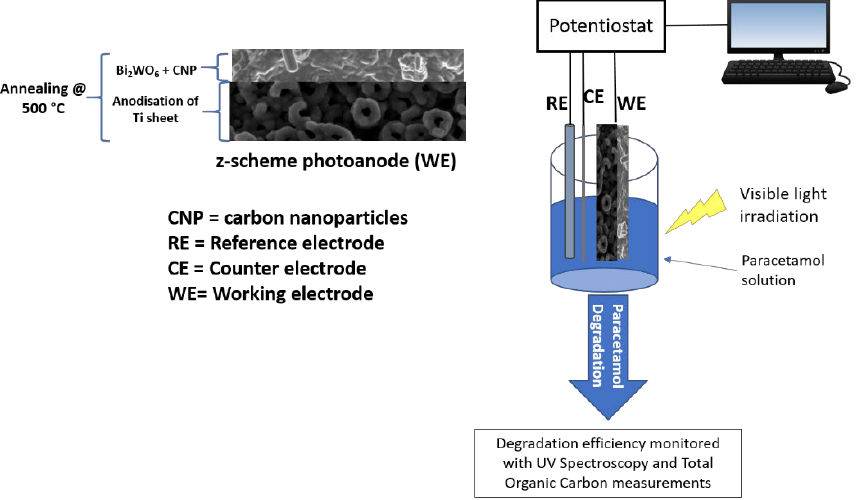
Figure 1. Schematic diagram of prepared Bi 2 WO 6 -CNP-TiO 2 NTA z-scheme photoanode used for photoelectrocatalytic degradation of paracetamol in a three-electrode cell.